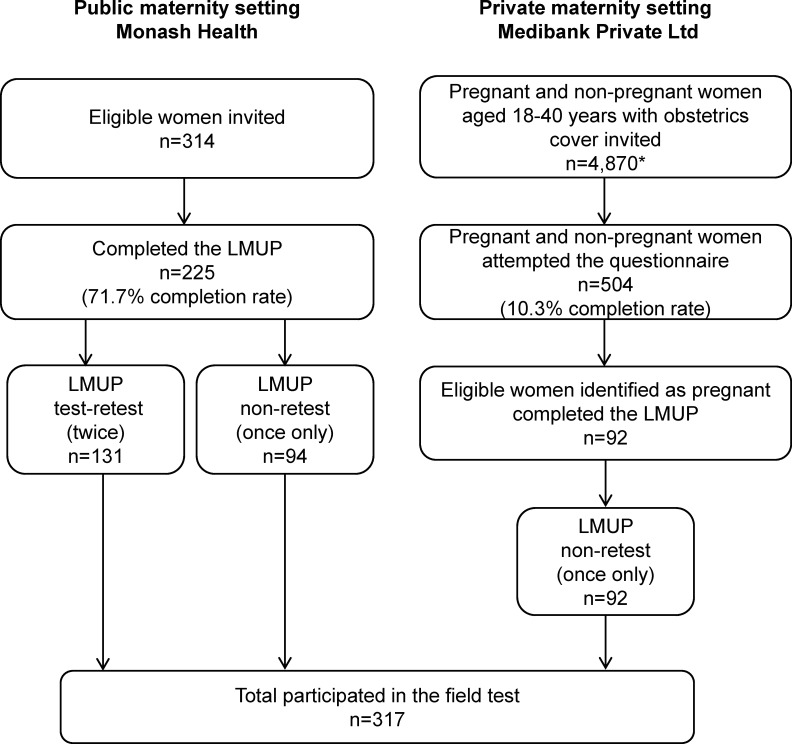
Recruitment and participation flow diagram.*56.8% of all invited women (n = 4,870) opened the original email invitation, 13.5% opened the questionnaire.